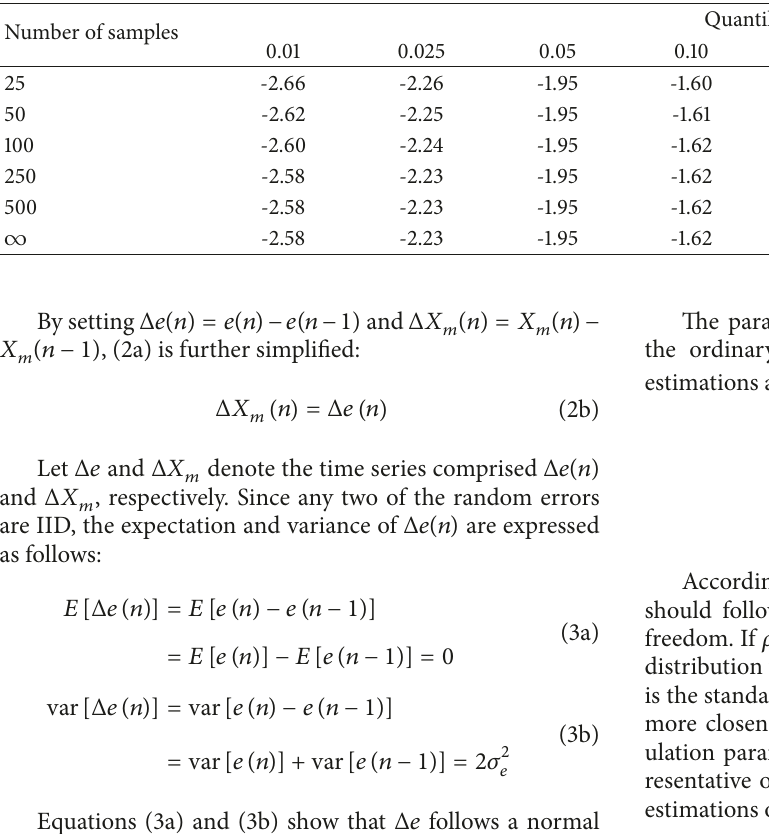
Table 1: Critical values of the DF